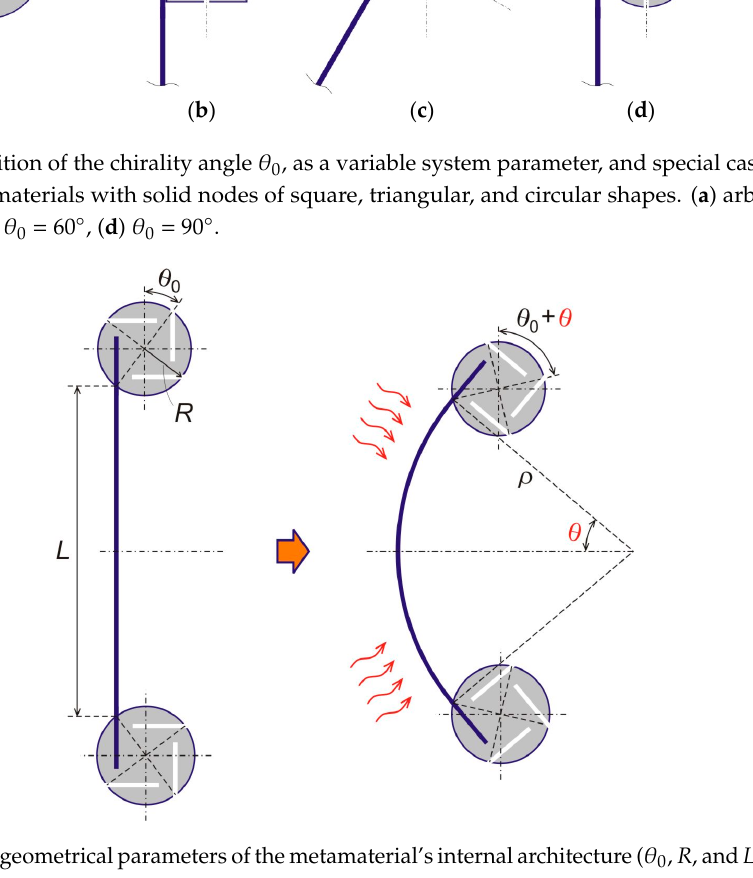
Figure 3. Three geometrical parameters of the metamaterial’s internal architecture ( θ 0 , R , and L ), and the node rotation angle ( θ ), as a single parameter to describe a thermally induced state of deformation. Here, 𝜌 = 𝐿/𝜃 is a radius of curvature of the thermally deformed strip.